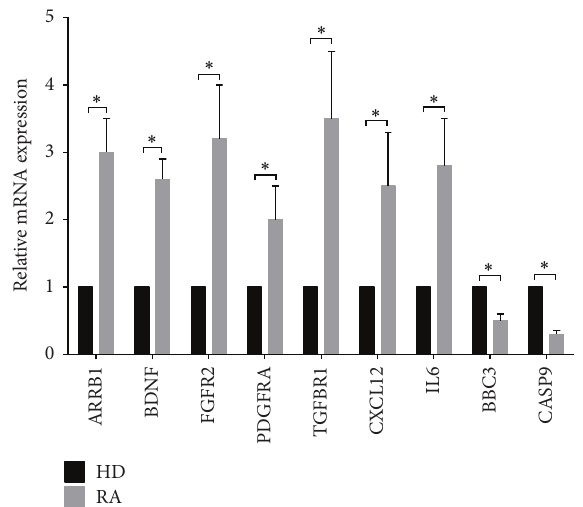
Figure 5: Quantitative real-time polymerase chain reaction (qRT- PCR) results of genes differentially expressed in SMSCs from RA patients and HDs. qRT-PCR was used to verify partial differentially expressed genes in the MAPK signaling, rheumatoid arthritis, and p53 pathways, including ARRB1, BDNF, FGR2, PDGFRA, TGFBR1, CXCL12, IL6, BBC3, and CASP9. The internal marker gene GAPDH was used for normalization. ∗ 𝑃 < 0.05